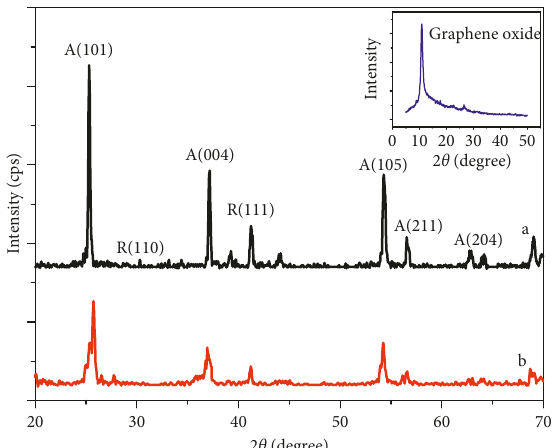
Figure 1: XRD spectrum of GO (inset), TiO